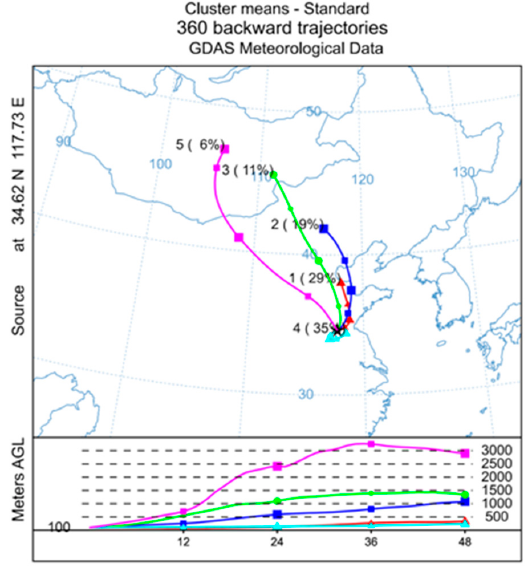
Figure 10. Cluster analysis of 48 h backward trajectories during the sampling period.